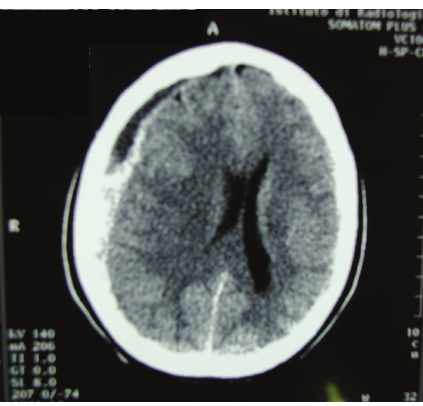
Figure 1: Cranial CT scan showing right sided subdural